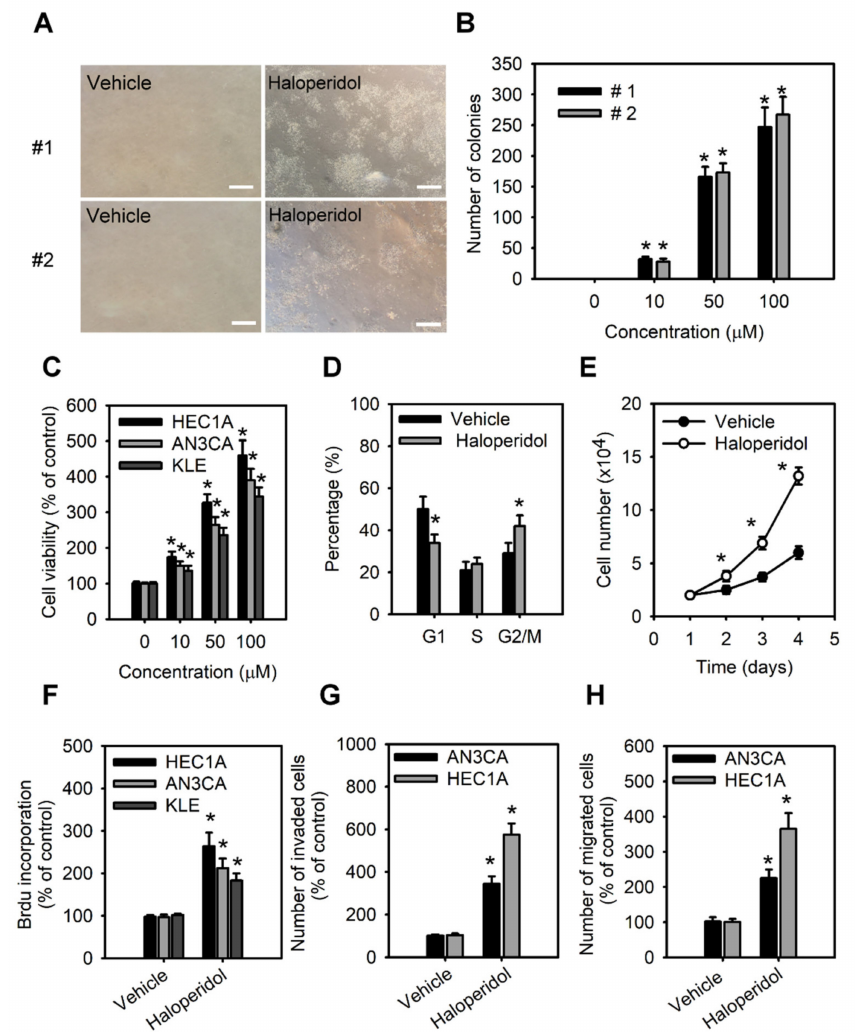
Figure 3. Haloperidol promotes the cellular transformation of human endometrial carcinoma cells (HECCs) and the malignant progression of HECCs. ( A ) Representative micrographs of colonies in soft agar colony formation assay of primary HEECs treated with haloperidol (100 µ M) for 28 days. ( B ) The number of colonies formed in soft agar for primary HEECs treated with 2 weeks of haloperidol (0–100 µ M). ( C ) Cell viability was increased in a dose-dependent manner by 0, 10, 50, and 100 µ M of haloperidol in HEC1A, AN3CA, and KLE cells for 48 h. ( D ) Cell cycle distribution of HEC1A cells receiving 10 µ M of haloperidol for 48 h. ( E ) Cell growth curve of HEC1A cells with or without 10 µ M of haloperidol in the culture medium. ( F ) The nuclear incorporation of bromodeoxyuridine (BrdU) in HEC1A, AN3CA, and KLE cells. Each received 10 µ M of haloperidol for 48 h. The invasion ( G ) and migration ( H ) of HEC1A and AN3CA cells. Each received 10 µ M of haloperidol for 48 h. Data are presented with means ± SD within triplicate experiments. * p < 0.01, compared with the untreated or vehicle group (normal